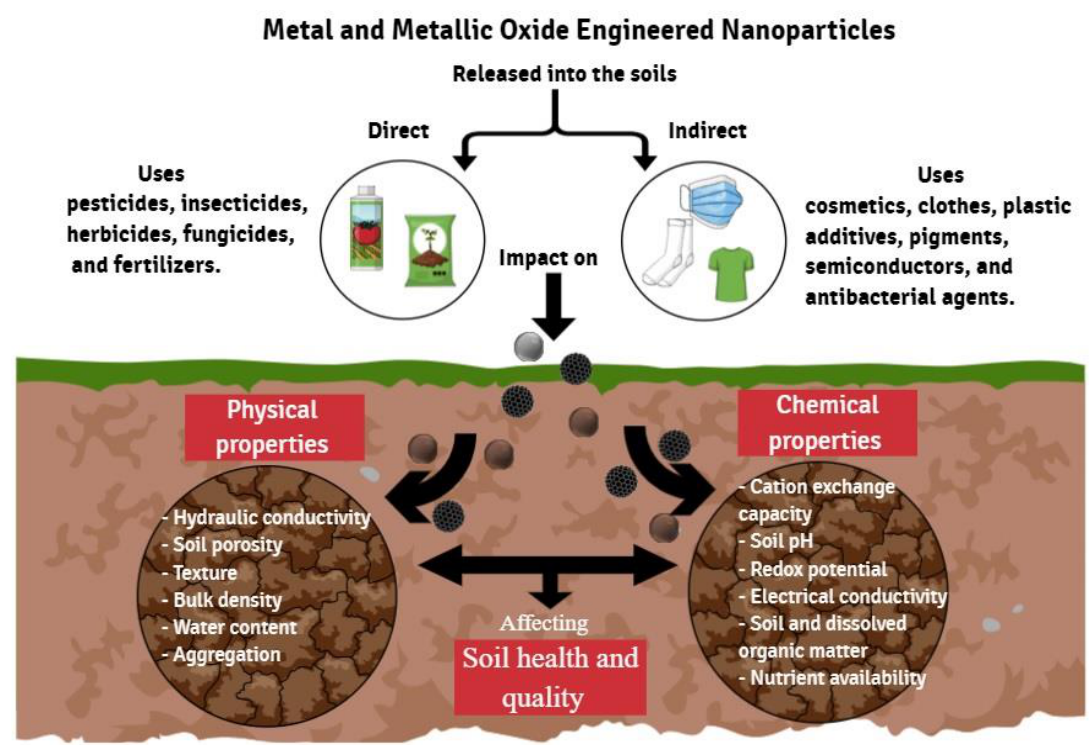
Figure 1. Summary of the impact of metal and metallic oxide engineered nanoparticles on physical and chemical soil properties.